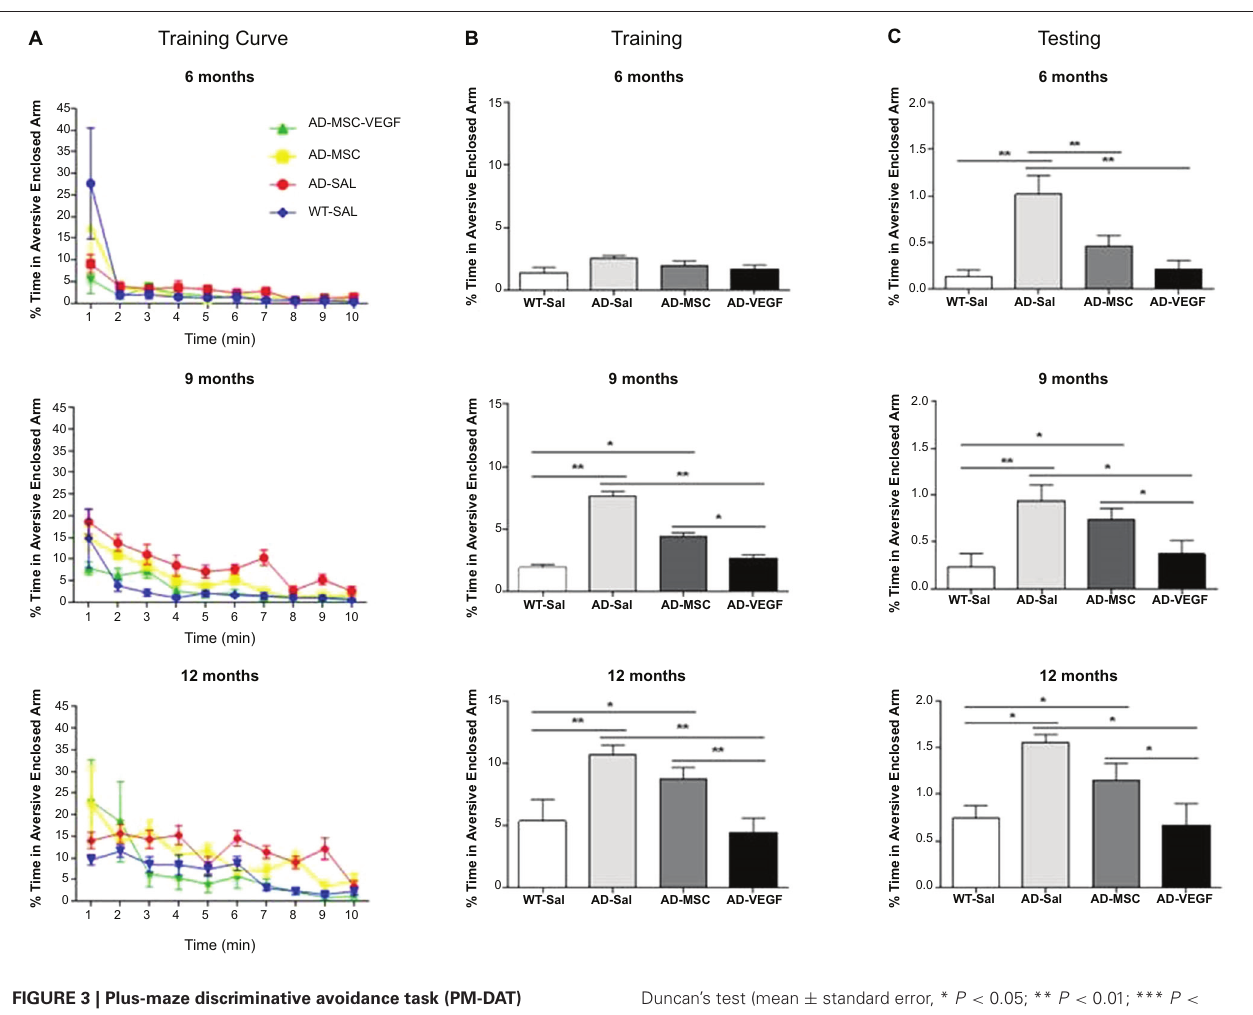
FIGURE 3 | Plus-maze discriminative avoidance task (PM-DAT) evaluation . The PM-DAT performance of the wild type (WT-SAL) and 2xTg-AD animals (AD-SAL; AD-MSC and AD-MSC-VEGF) during the training (A and B) and testing (C) for the three ages. ANOVA followed by post hoc